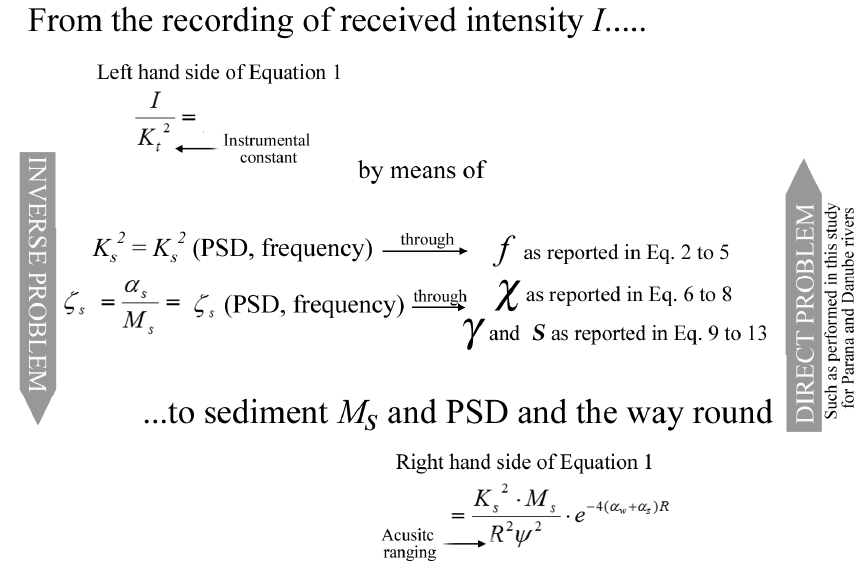
Figure 3. Sketch summarizing the use of most important parameters in Equations (2)–(13) to be applied while solving Equation (1) with a direct and an inverse approach.